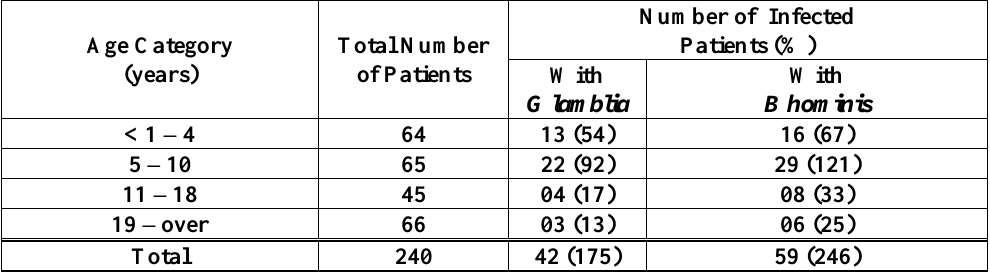
Table (2): Number and percentage of patients infected with G lamblia and B hominis within four categories of